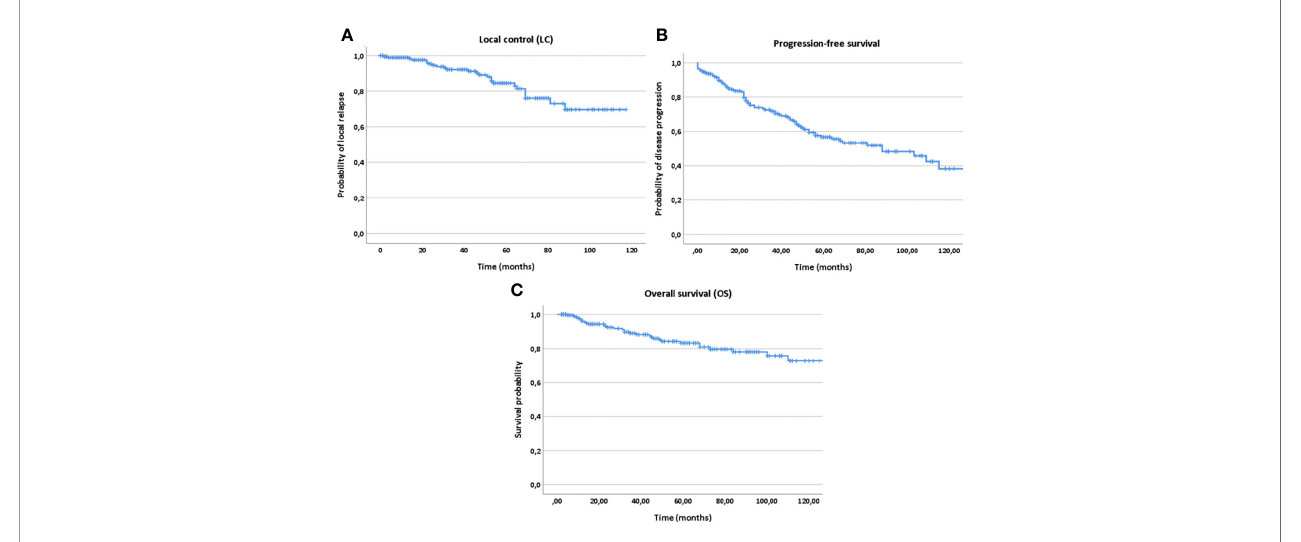
FIGURE 2 | Kaplan-Meier estimates for local control (A) , progression-free survival (B) and overall survival (C) for all patients (n=207).